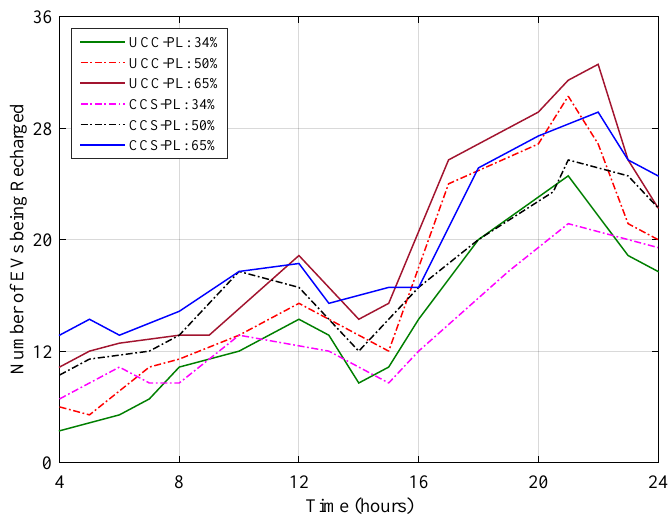
Figure 11. EV charging pattern during a typical day of August weekend.